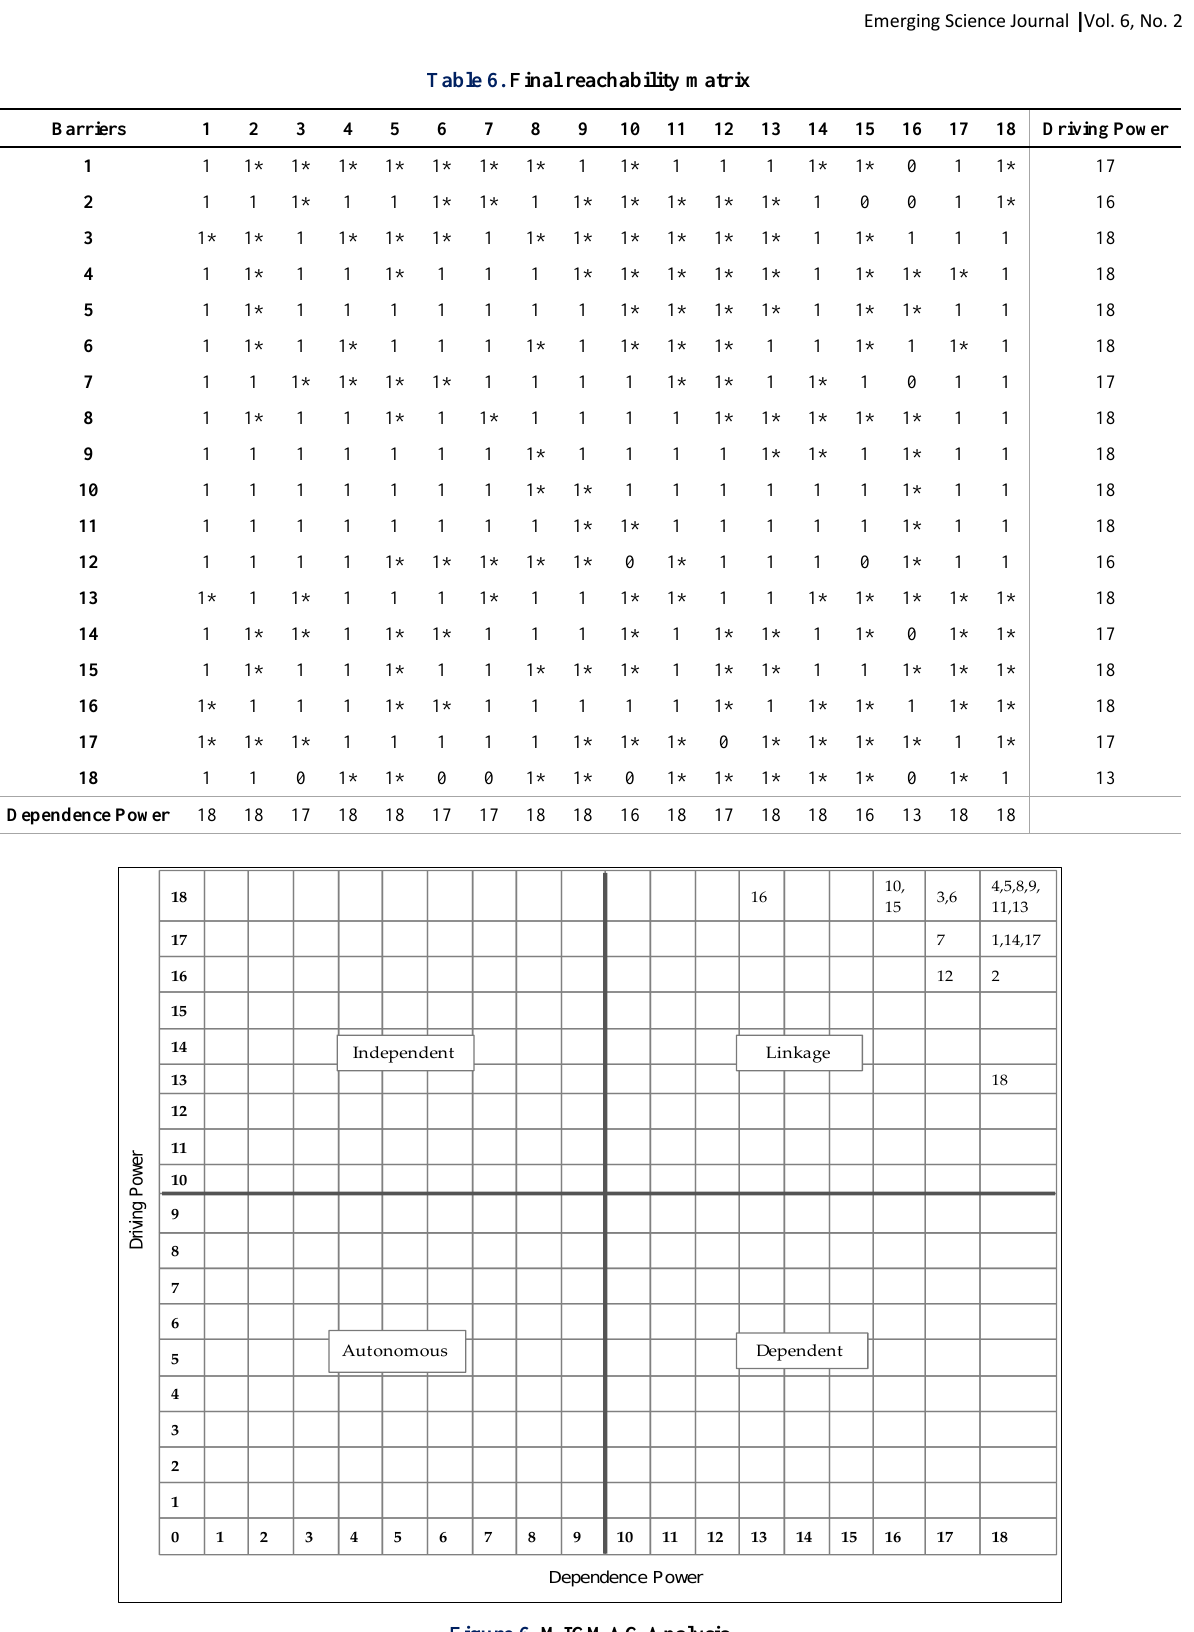
Figure 6. MICMAC